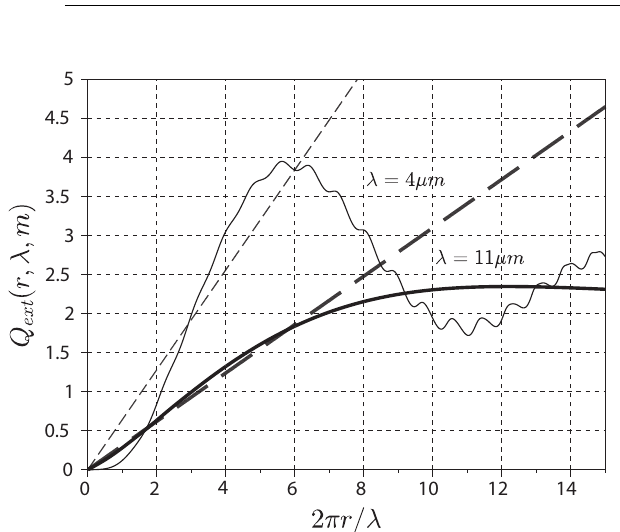
Fig. 2. Extinction efficiency Q ext (r,λ,m) as a function of the size parameter 2 πr/λ for λ = 4µm (thin line) and λ = 11µm (thick line). Q ext (r,λ,m) was computed with the Matlab implemen- tation of Mie theory by Mätzler (2002). The dashes show the linear approximations (thin = 4µm; thick = 11µm) suggested by Chylek (1978).